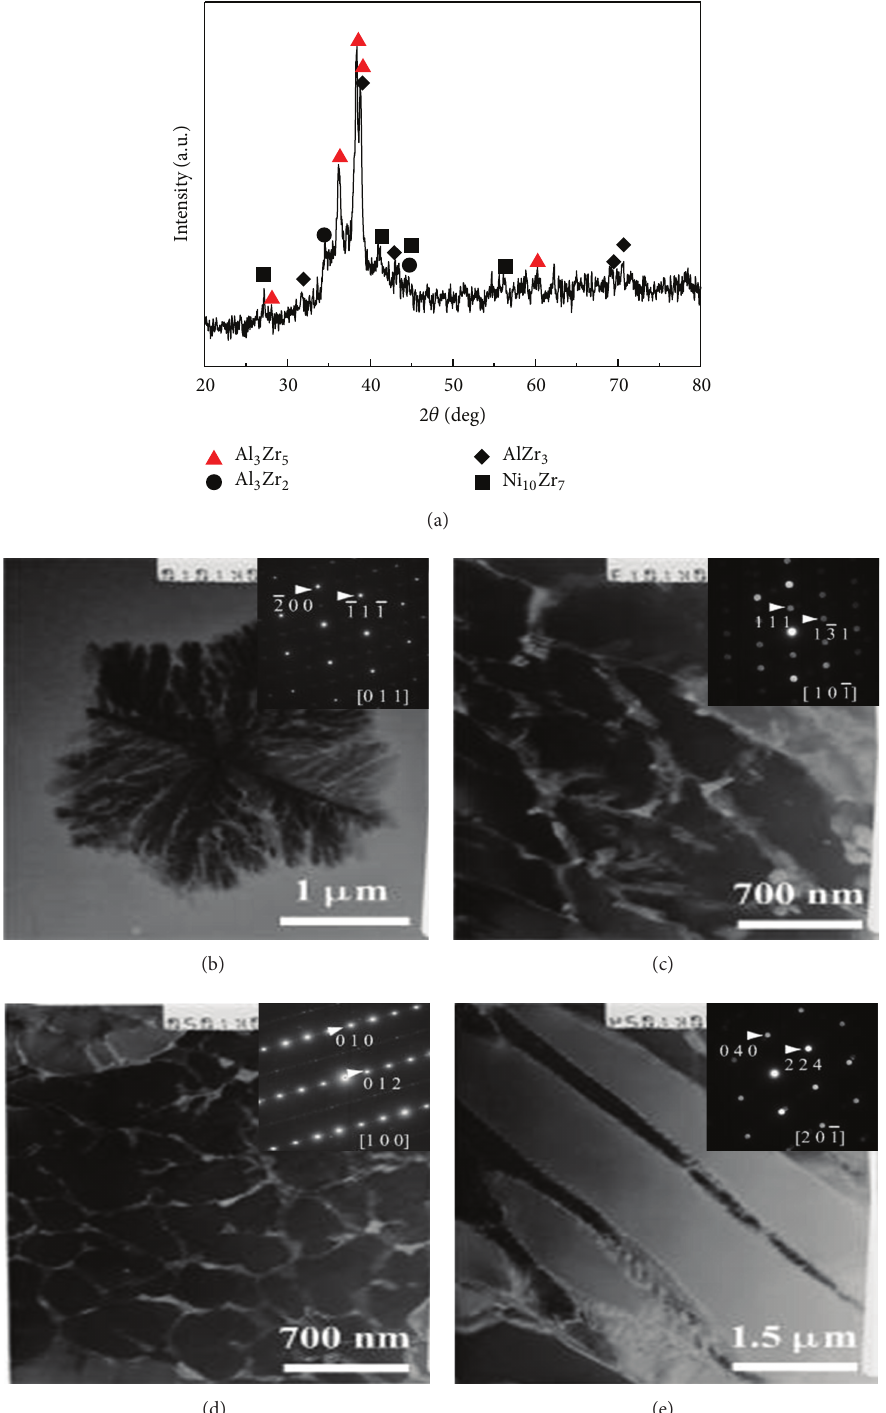
Figure 5: XRD pattern (a) and bright-field TEM images with corresponding SAED patterns (b–e) for location #3. The crystalline phases in (b), (c), (d), and (e) are the cubic AlZr 3 , the orthorhombic Al 3 Zr 2 , the hexagonal Al 3 Zr 5 , and the orthorhombic Ni 10 Zr 7 ,